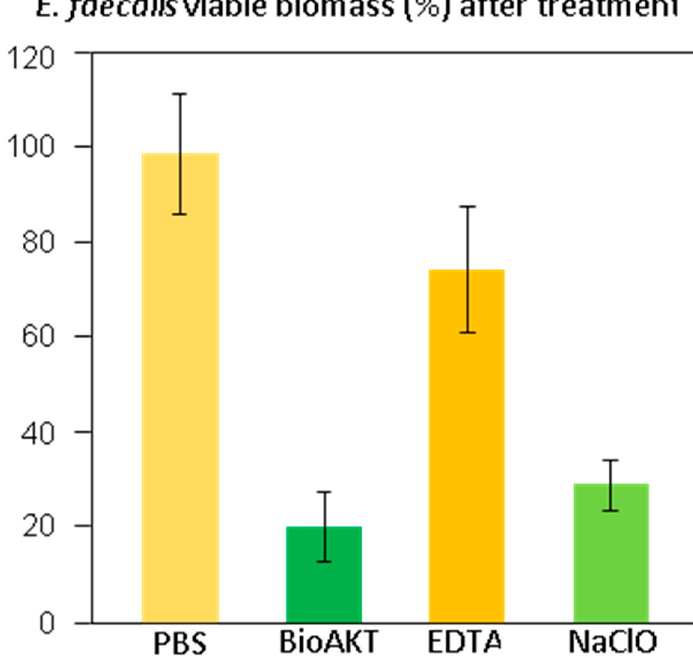
Figure 6. This graph shows the viable Enterococcus faecalis biomass adherent to the dentin surfaces after the different treatments. Results are given in % of viable biomass ± 1 standard deviation, assuming PBS treatment as 100% viability and after removing the blank.